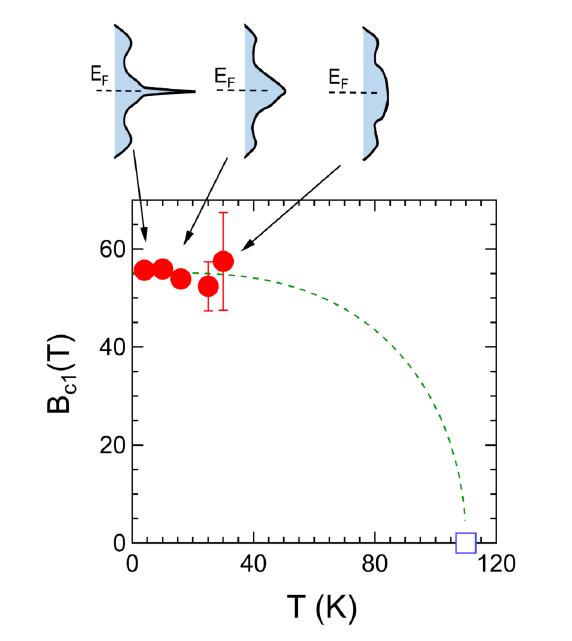
Figure 3. Temperature dependencies of B c evaluated from dM / dB curves are potted with filled circles. The critical temperature ( T c ) at zero fields reported is around 100 K (an open square) [8]. The DOSs at the transition magnetic fields at different temperatures are schematically shown in upper part of the figure. They are handwritten drawings based on the DOSs calculated theoretically at zero Kelvin